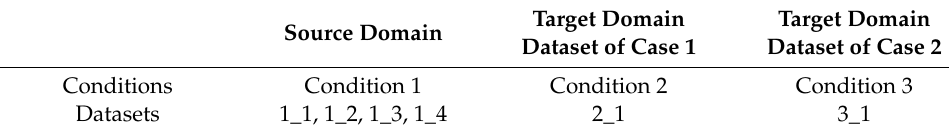
Figure 6. Vibration signals and RMS of ( a ) bearing 1_1; ( b ) bearing 1_2; ( c ) bearing 1_3; ( d ) bearing 1_4. Table 1. Description of datasets.